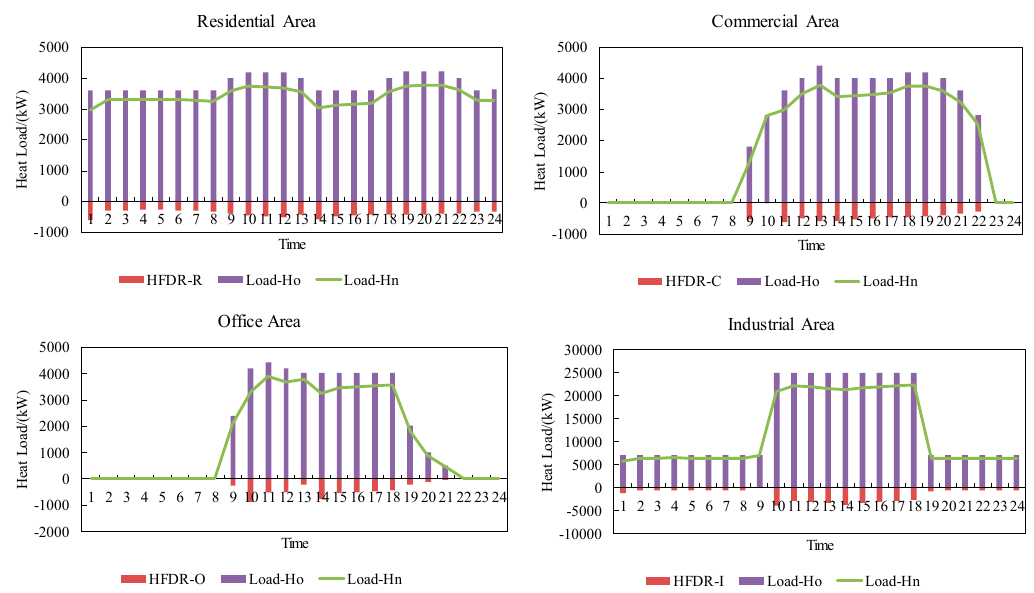
Figure 7. Indoor temperature of multi-district IES.